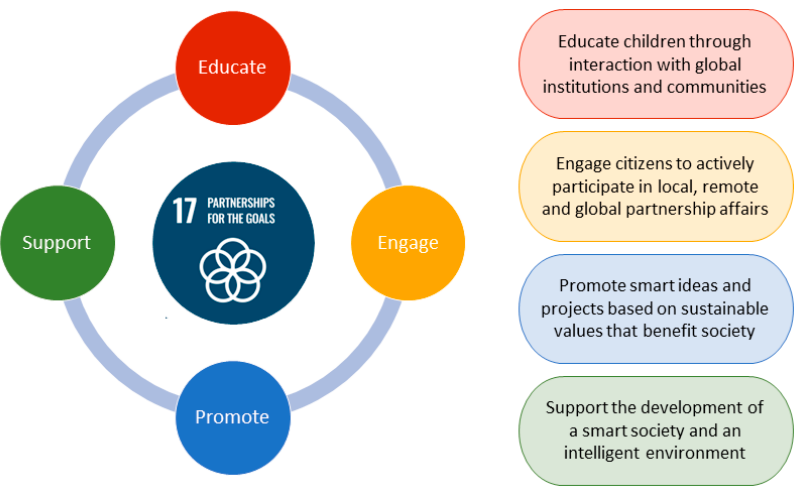
Figure 1. The role of a digital platform in achieving the SDGs by offering an environment for educating, engaging, promoting, and supporting partnerships between stakeholders.